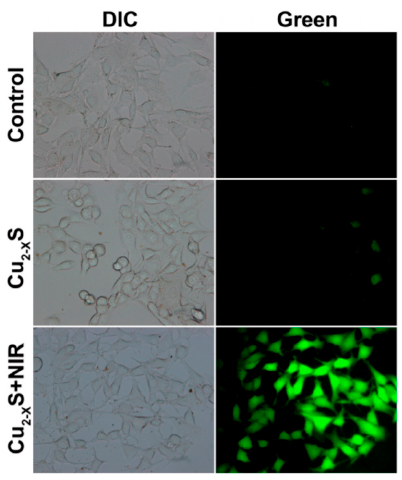
Figure 3. Visible light and fluorescence images of B16 cells incubated with plasmonic Cu 2 − x S nanocrystals for 6 h (Reproduced with permission [120]).